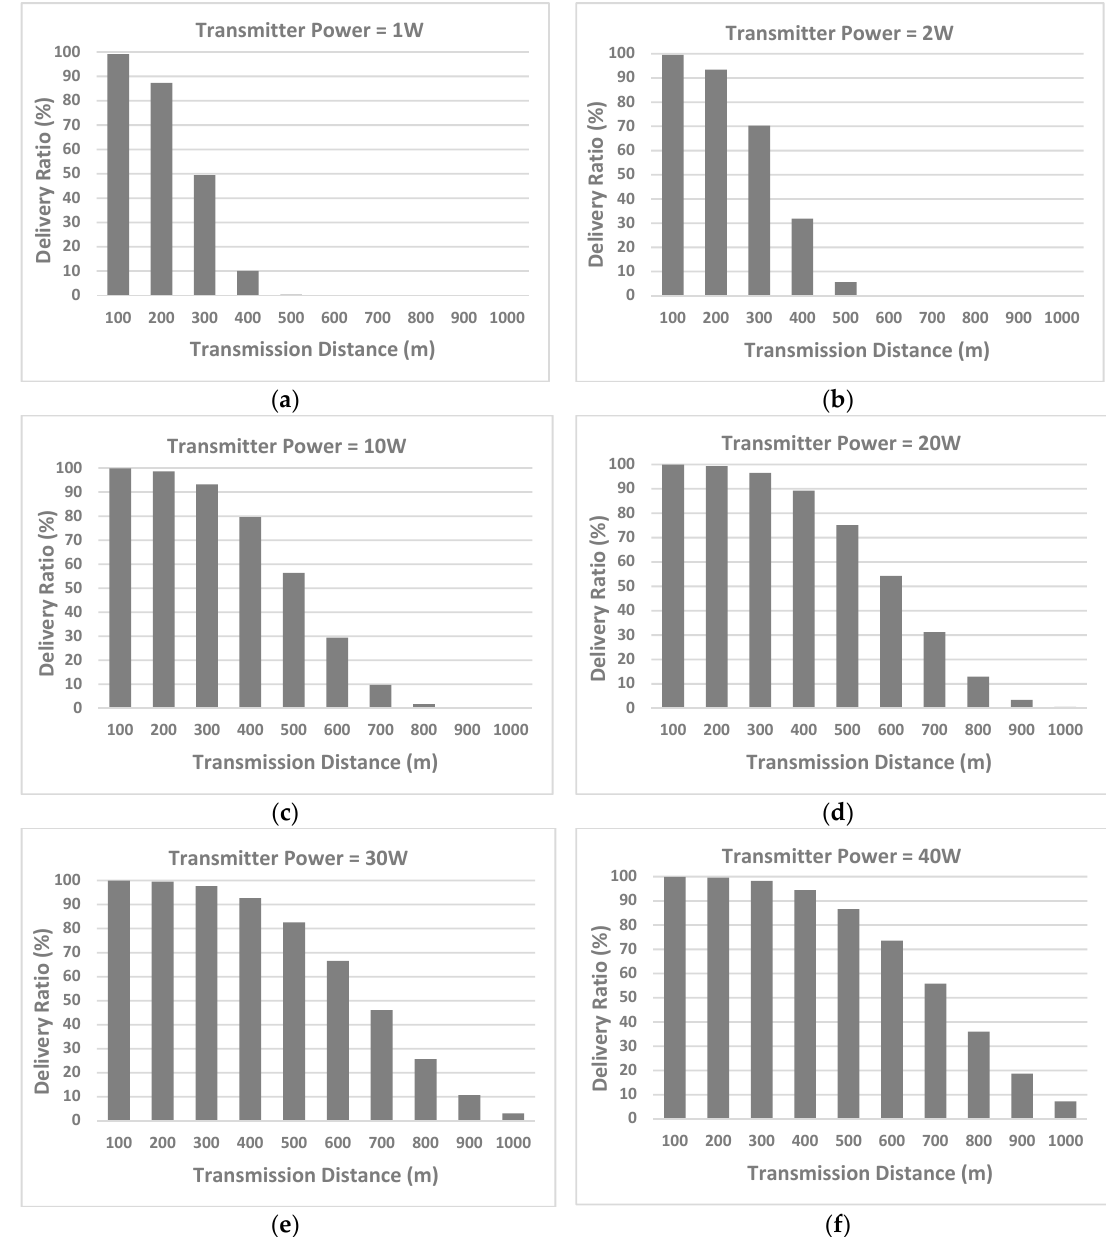
Figure 5. Simulation results of the successful delivery ratio when the channel models are applied to different transmitter powers (1–40 W) and distances (100–1000 m) ( a ) Transmitter power = 1 W; ( b ) Transmitter power = 2 W; ( c ) Transmitter power = 10 W; ( d ) Transmitter power = 20 W; ( e ) Transmitter power = 30 W; ( f ) Transmitter power = 40 W.